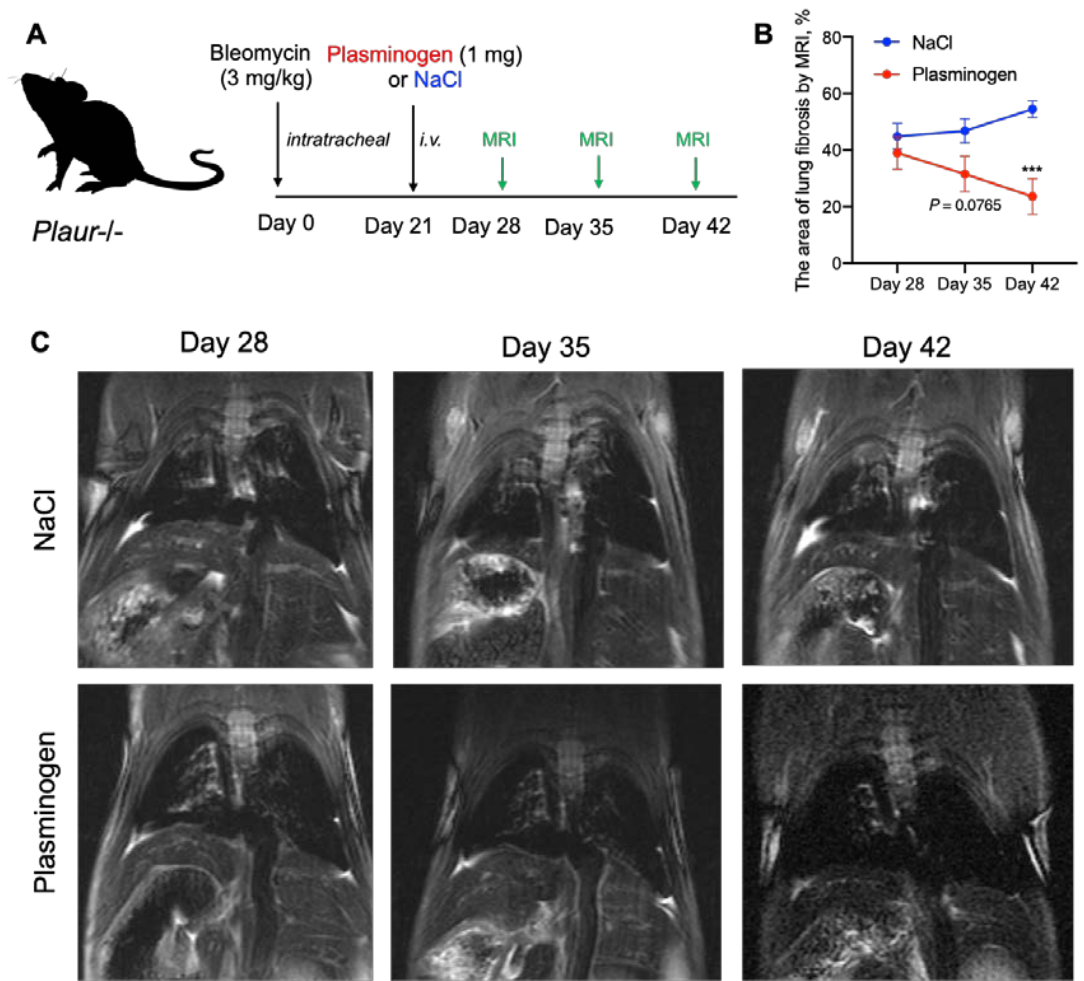
Figure 9. Treatment with plasminogen decreased bleomycin-induced lung fibrosis. ( A ) Overview of the experimental design. Plaur -/- mice were subjected to intratracheal instillation with bleomycin (3 mg/kg) at day 0. On Day 21, mice were treated with 1 mg plasminogen ( n = 6) or isotonic NaCl (control, n = 7) intravenously (i.v.). MRI was performed to assess lung fibrosis on Day 28, Day 35 and Day 42 after bleomycin administration. ( B ) The % of lung tissue with fibrosis assessed by MRI at day 28, 35 or 42 of bleomycin intratracheal instillation in Plaur -/- mice, treated with 1 mg plas- minogen or isotonic NaCl (control) intravenously at day 21. Data are presented as the mean ± SEM. *** p < 0.001, 2-way ANOVA, Holm–Šídák’s test. ( C ) Typical MRI images obtained 28, 35 or 42 days after bleomycin administration to Plaur -/- mice treated with plasminogen or NaCl (control) intrave- nously. For illustrative purposes, the images were taken from one and the same mouse in each group.